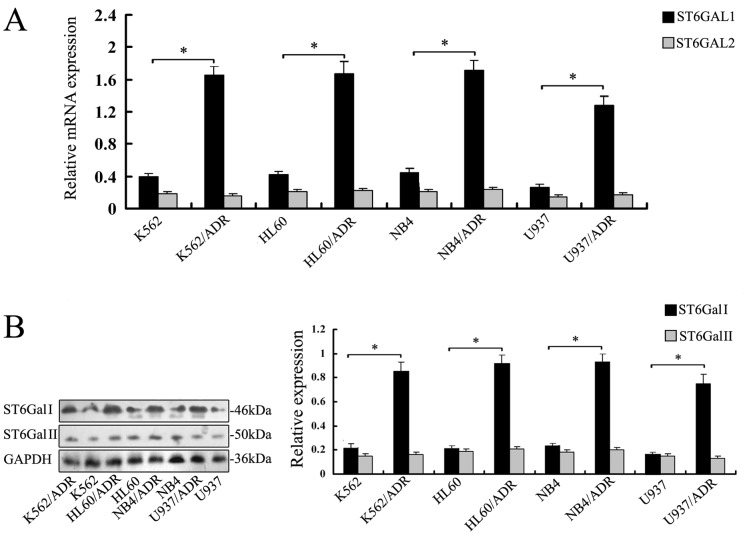
Differential expression of ST6GAL1 and ST6GAL2 in four pairs of leukemia cell lines.(A) The mRNA levels of ST6GAL1 and ST6GAL2 analyzed by real-time PCR. Four ADR cells expressed higher levels of ST6GAL1 mRNA than their parental cell types (*P<0.05). No significant changes of ST6GAL2 were observed. (B) Western blotting analysis of ST6GalI and ST6GalII at protein levels. GAPDH served as a control. Data are the means ± SD of triplicate determinants.